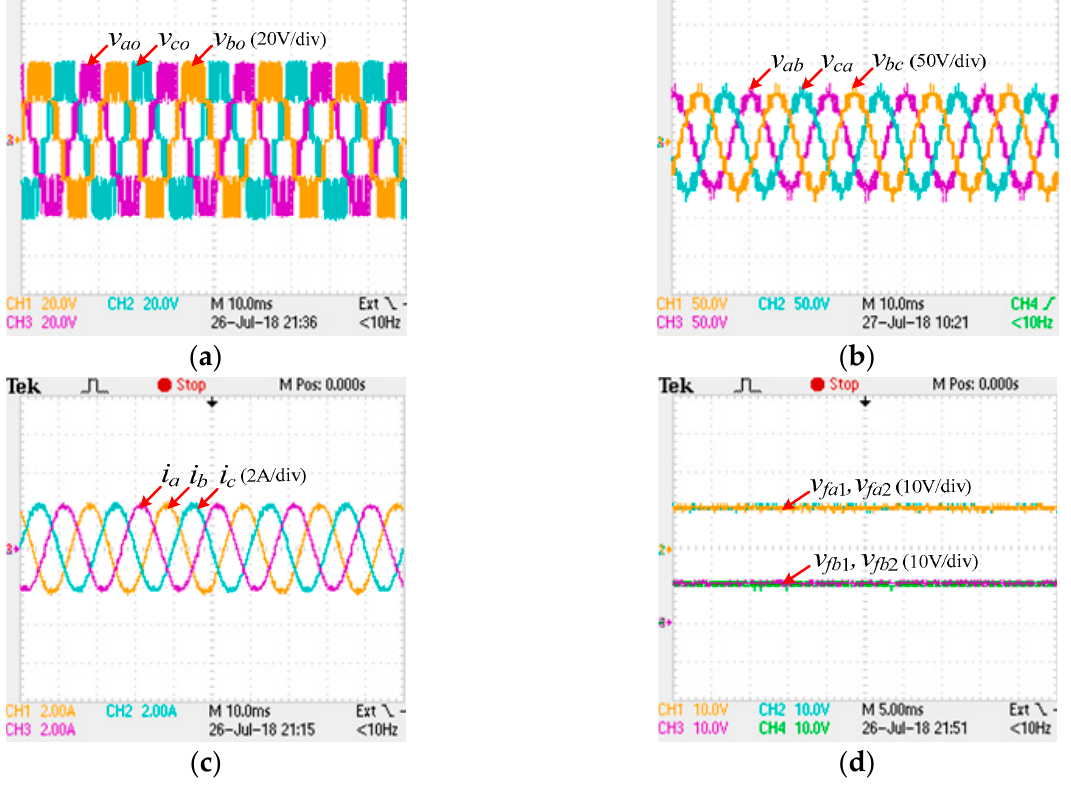
Figure 27. Steady ‐ state experiment results of three ‐ phase 5L hybrid T ‐ ANPC converter with RL ‐ load Figure 27. Steady-state experiment results of three-phase 5L hybrid T-ANPC converter with RL -load ( m = 0.9 and f c = 2 kHz). ( a ) Phase voltages, ( b ) line-to-line voltages, ( c ) load currents, ( d ) FC voltages ( m = 0.9 and f c = 2 kHz). ( a ) Phase voltages, ( b ) line ‐ to ‐ line voltages, ( c ) load currents, ( d ) FC voltages of A and B of A and B phases.